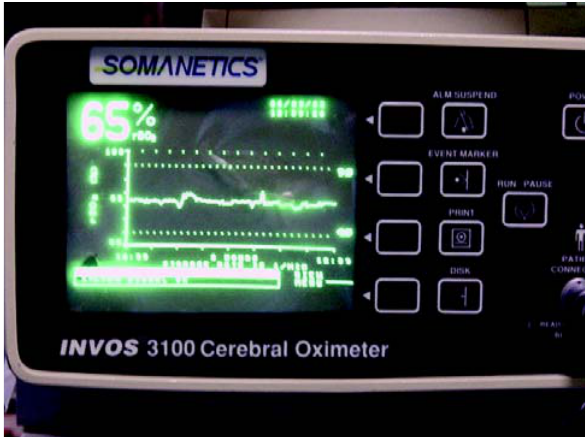
Fig.1 - Sistema Somanetics, baseado na espectroscopia, utilizado para a oximetria cerebral